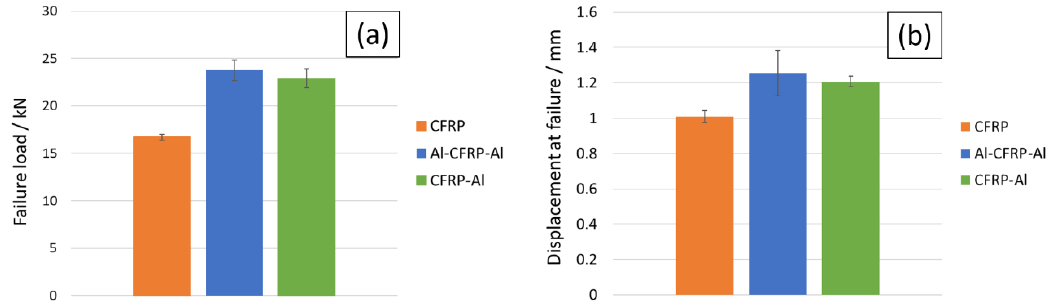
Figure 10. Different geometries ’ failure values for experimental load ( a ) and displacement ( b ).